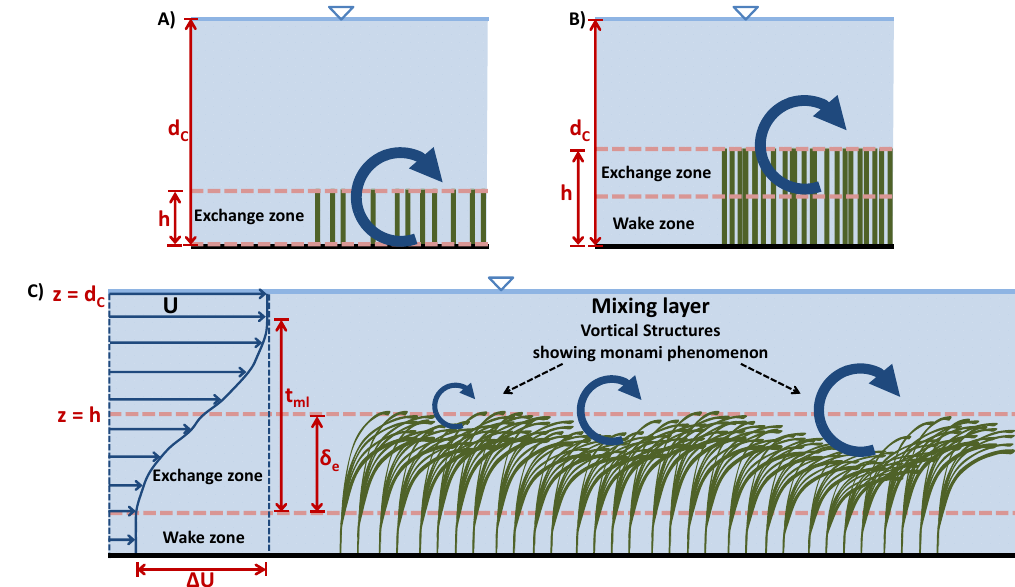
Fig. 9. Schematics of the flow field for submerged aquatic vegetation. (A) Influence of deep submergence and sparse canopy on mixing layer penetration depth. (B) Influence of shallow submergence and a dense canopy on mixing layer penetration depth. (C) Flow structure within a flexible submerged canopy showing monami phenomenon. (Figure adapted from Ghisalberti and Nepf, 2002, 2005, Nepf et al., 2007, Nepf and Ghisalberti, 2008, and Nepf,